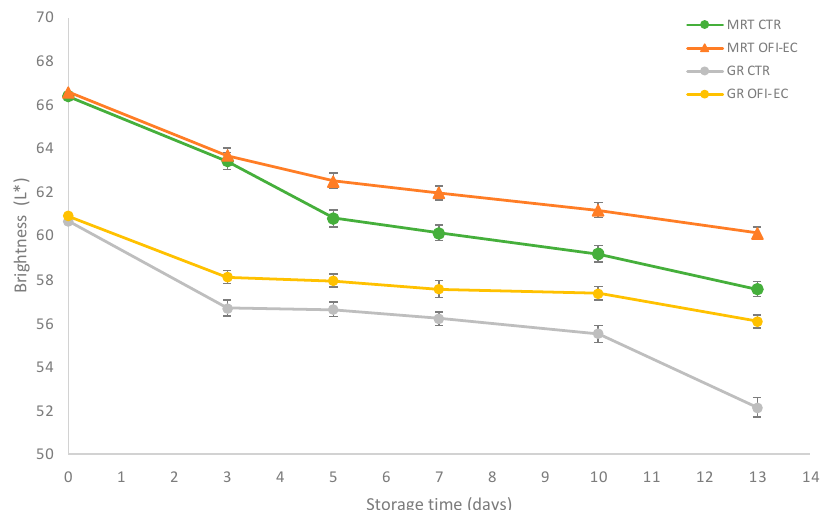
Figure 3. Changes in brightness (L*) in minimally processed loquat (cv Martorana and Gigante Rossa ), untreated fruit (CTR), and fruits treated with mucilage (OFI-EC) during cold storage (13 days at 5 °C). Data are the mean ± SE (bars represent standard error of the means; n = 5).